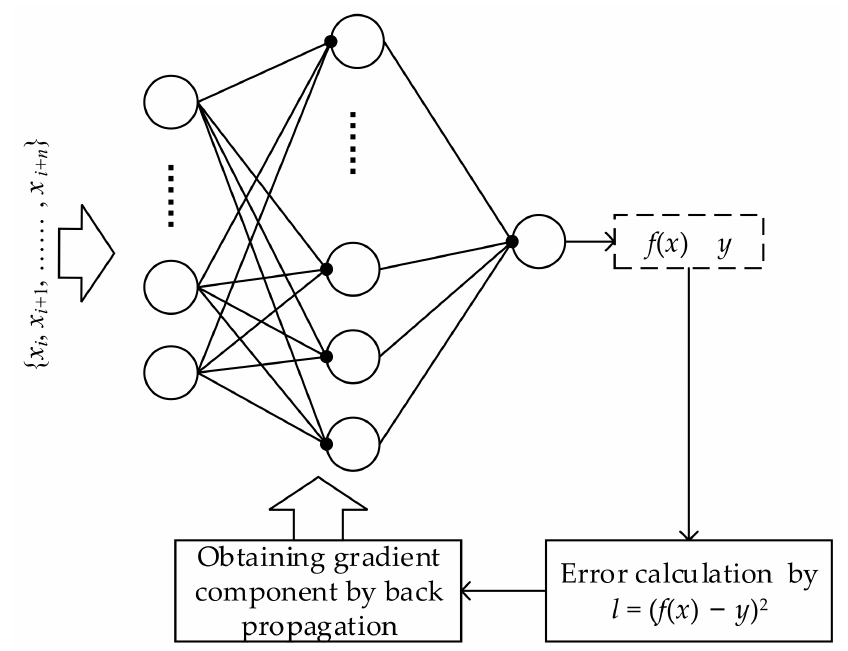
Figure 6. Neural network